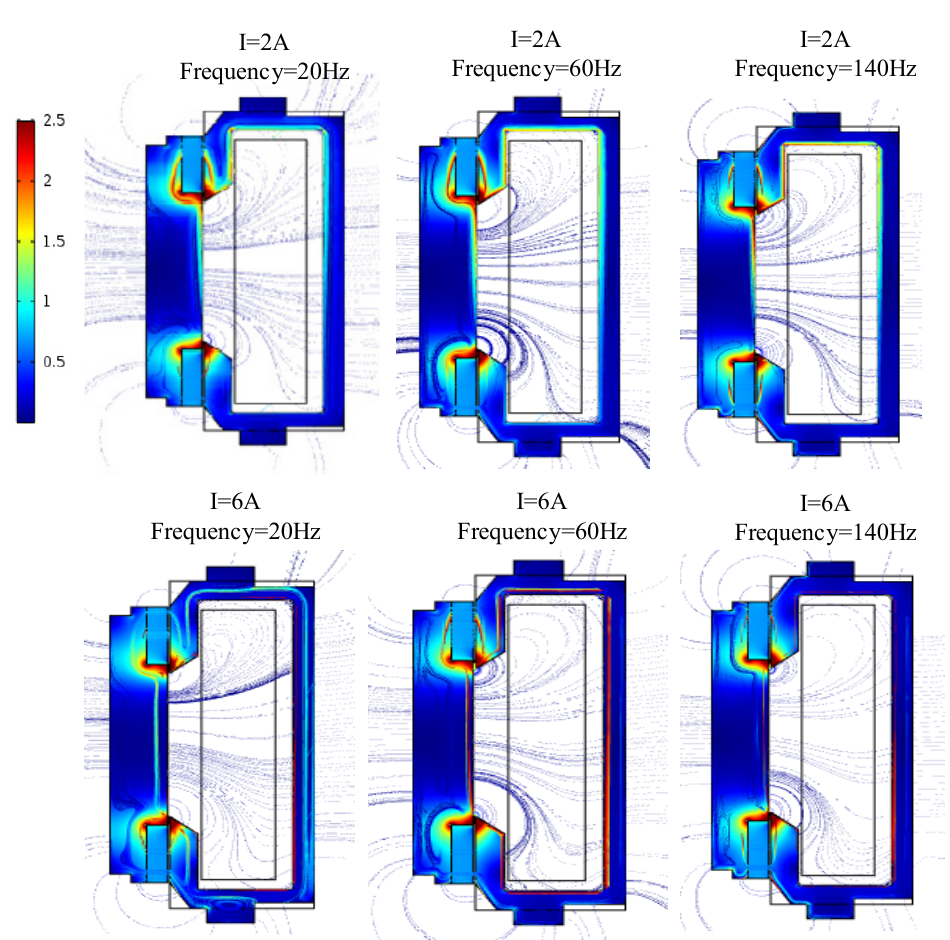
Figure 4. Magnetic induction intensity at different current amplitudes and frequencies. As can be seen from Figure 4, when the excitation current amplitude is constant and the frequency increases, the magnetic induction line tends to the inner surface of the stator core. When the excitation current frequency is constant and the amplitude increases, the intensity of magnetic induction line increases obviously, which is consistent with the the ‐ ory [25–28].